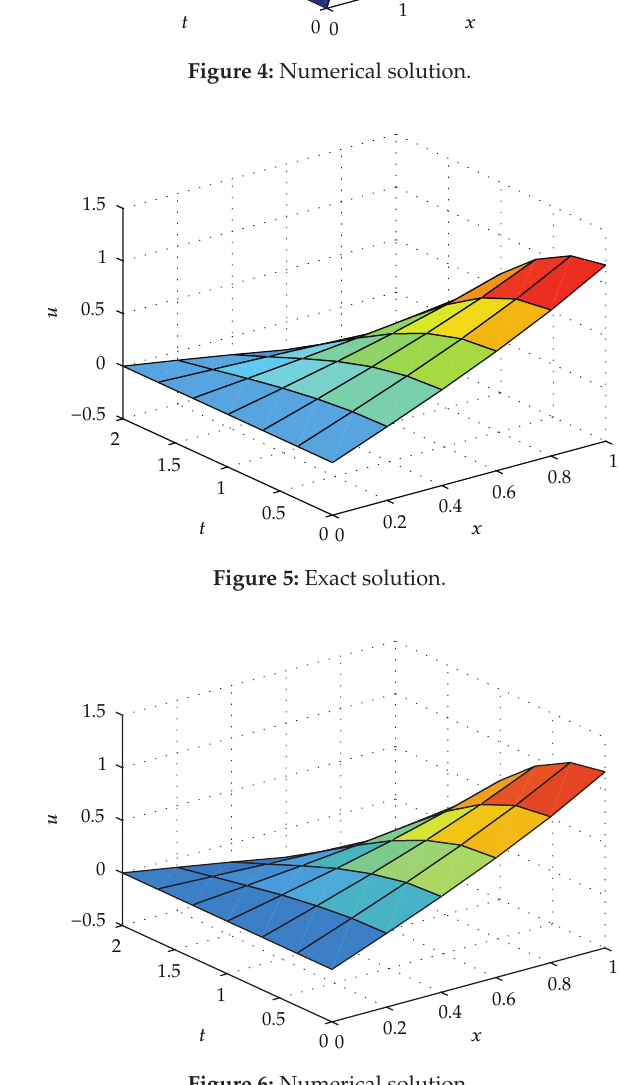
Figure 6: Numerical